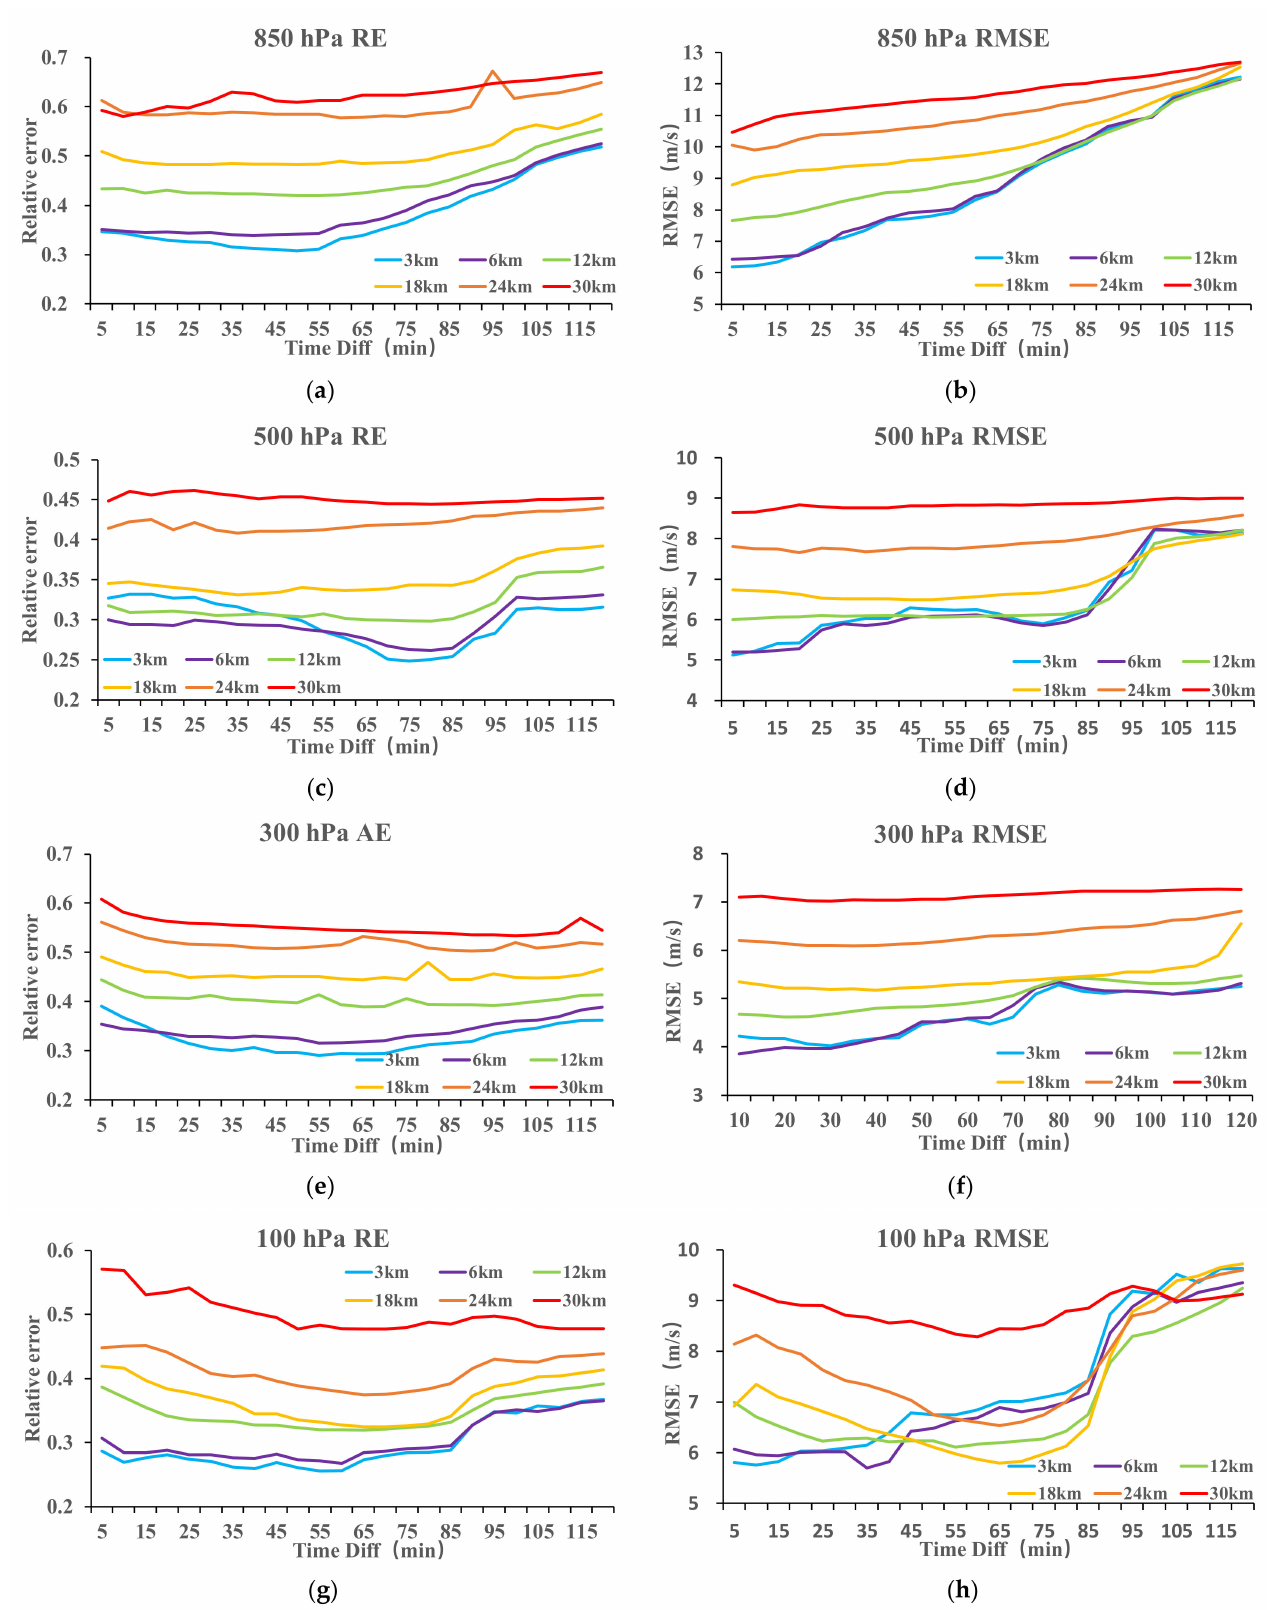
Figure 6. The relative error ( a , c , e , g ) and the root mean square error ( b , d , f , h ) with different FOV sizes (shown as lines of different colors): 3, 6, 12, 18, 24, and 30 km. The X-axis represents satellite revisiting time ranging from 5 to 120 min in 5 min